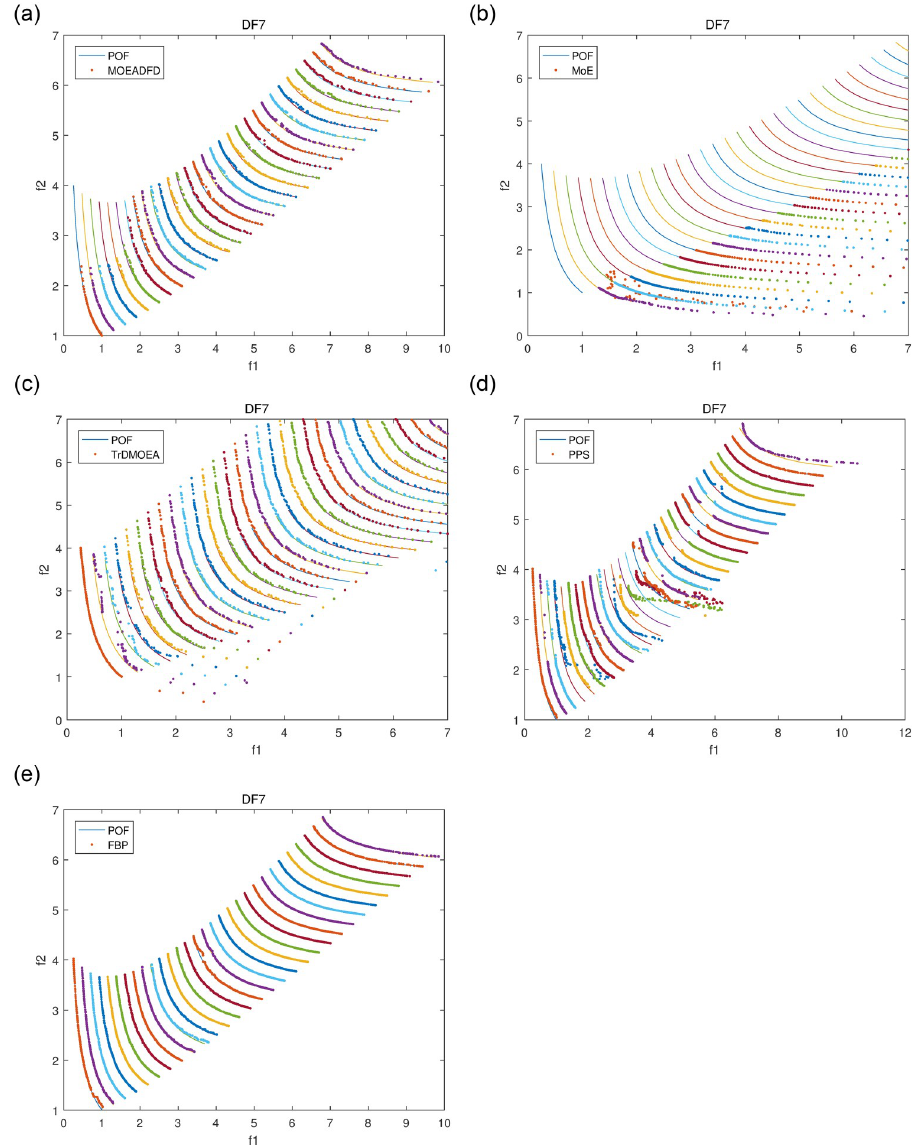
Fig 6. POF approximations of five algorithms for DF7 with n